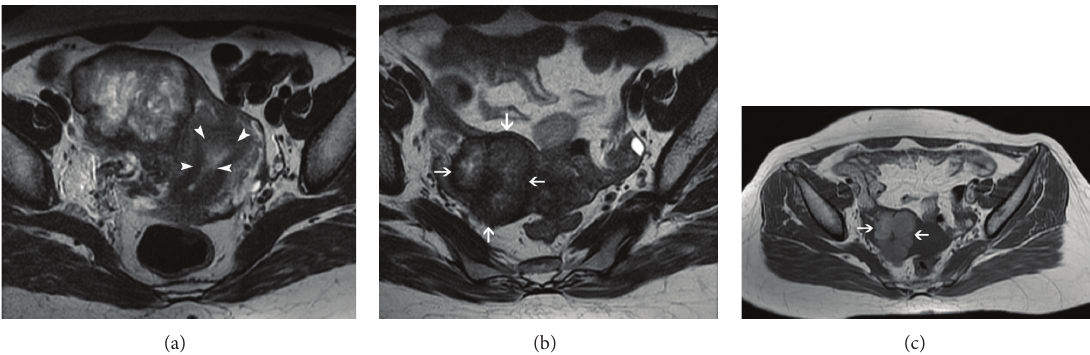
Figure 10: Choriocarcinoma in a 22-year-old patient with extremely raised 𝛽 -hCG levels, 3 months after an abortion. Axial T2-weighted MR image (a) reveals a heterogeneous, hyperintense mass in the right lateral myometrium with parametrial extension. Note is made of a relatively preserved endometrial cavity (arrowheads). Postchemotherapy follow-up MRI ((b), (c)) demonstrates interval regression of the trophoblastic tumor (arrows) with reduction in its size, heterogeneity, and signal hyperintensity on T2-weighted image (b). Hyperintense signal of the lesion (arrows) on T1-weighted image (c) indicates intralesional hemorrhage, a known occurrence following chemotherapy.